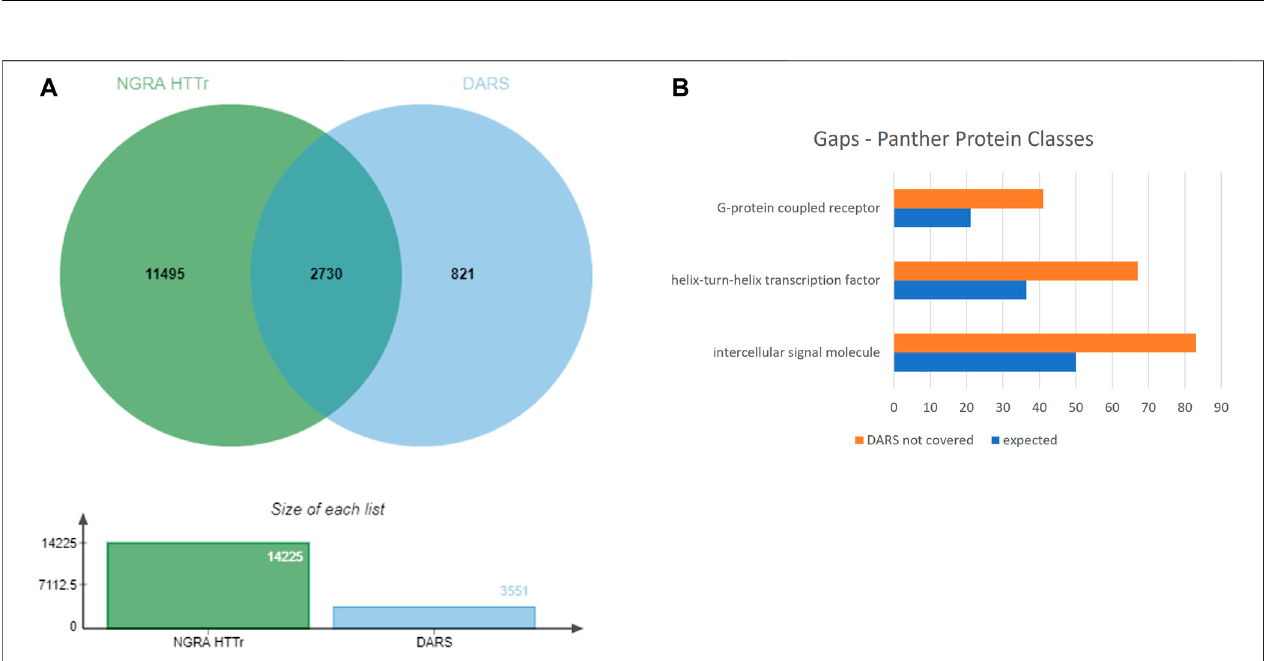
FIGURE 8 | (A) Coverage of DARS genes by NGRA HTTr cell lines (B) Protein classes represented in the gaps remaining in DARS gene coverage.